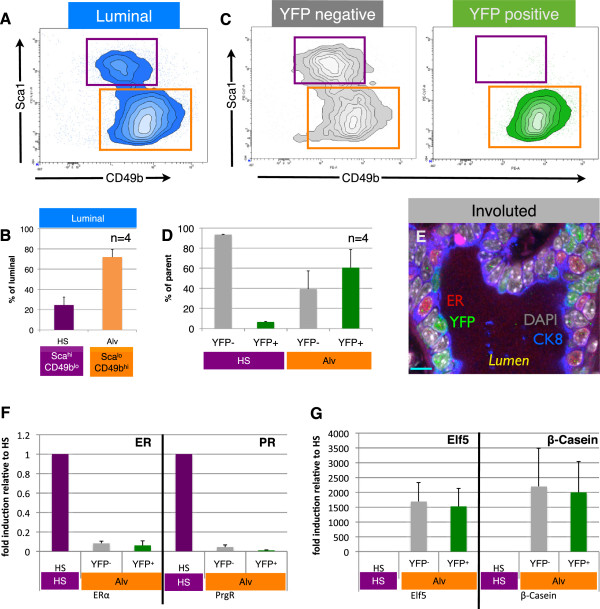
Parity-identified mammary epithelial cells (PI-MECs) in involuted mammary glands belong to the alveolar progenitor population. (A) The luminal population of mammary epithelial cells (CD24hi CD49flo) is separated into hormone-sensing cells (Sca1hi CD49blo; purple gate) and alveolar progenitor cells (Sca1lo CD49bhi; orange gate). (B) Relative proportions of hormone-sensing (HS) cells and alveolar progenitor cells (Alv) within the luminal population. (C) Analysis of yellow fluorescent protein-negative (YFPneg) (grey) and YFPpos (PI-MEC, green) subpopulations of luminal cells shows that PI-MECs are found mainly in the alveolar progenitor cell population (orange gate). Note that the combined density/contour plot shows the relative distribution of the population on display and therefore the HS population appears larger in (C) than in (A) because the YFPpos population is plotted separately in (C). (D) Distribution of YFPneg cells and YFPpos PI-MECs within populations of HS cells (Sca1hi CD49blo; purple label) and of alveolar progenitor cells (Sca1lo CD49bhi; orange label). (E) Immunofluorescent probing of an involuted mammary section identifies three luminal cell types: HS cells expressing the estrogen receptor alpha (ERα) (red), PI-MECs expressing YFP (green), and luminal cells expressing CK8 (blue) but neither ER nor YFP. Bar is 10 μm. (F) Relative mRNA expression levels of HS cell marker genes ERα and progesterone receptor (PR) and (G) alveolar cell marker genes Elf5 and β-Casein on populations of sorted HS cells (Sca1hiCD49blo) or alveolar progenitor cells (Sca1loCD49bhi) which were separated based on their YFP expression. Error bars indicate standard deviation for four individual mice.